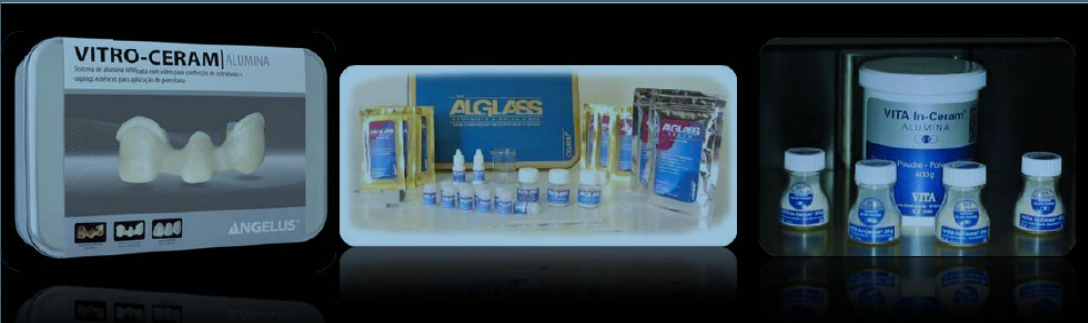
Figure 1. Al 2 O 3 commercial powders used in this research (Vitro-ceram, Alglass and In-ceram).